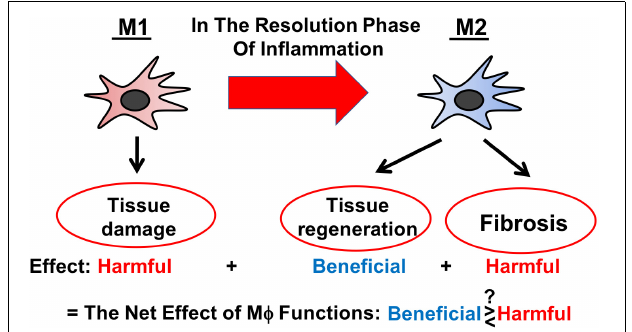
FIGURE 2 | Schematic representation of M φ fate in embryogenesis and